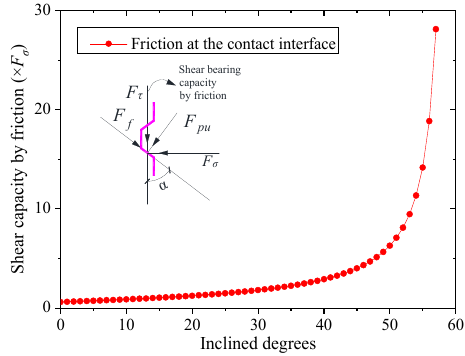
Figure 13. Friction varied with inclined degrees.